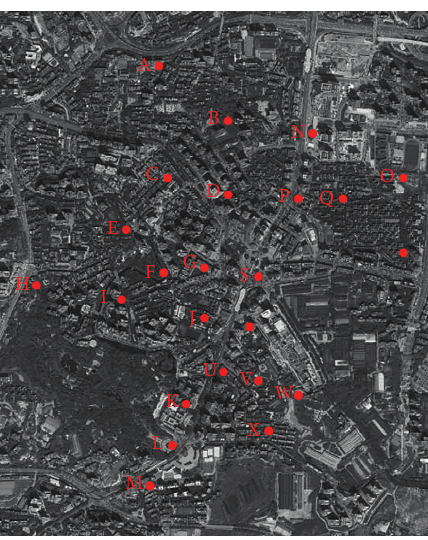
Figure 2: Location of the 24 measurement